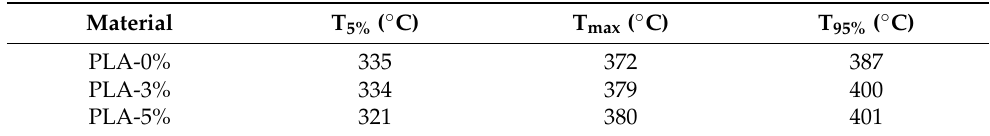
Table 4. Onset degradation temperature (T5%), temperature of maximum degradation rate (Tmax), and endset degradation temperature (T95%) for PLA and the formulations with CaCO 3 .